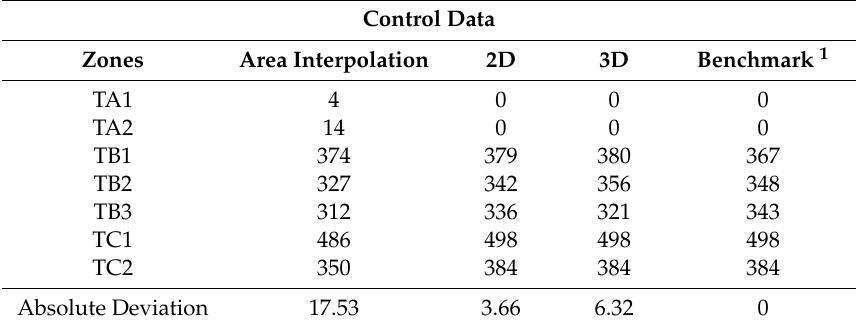
Table 2. Estimated population in 2001 according to 2011 census tracts (refer to Figure 2).